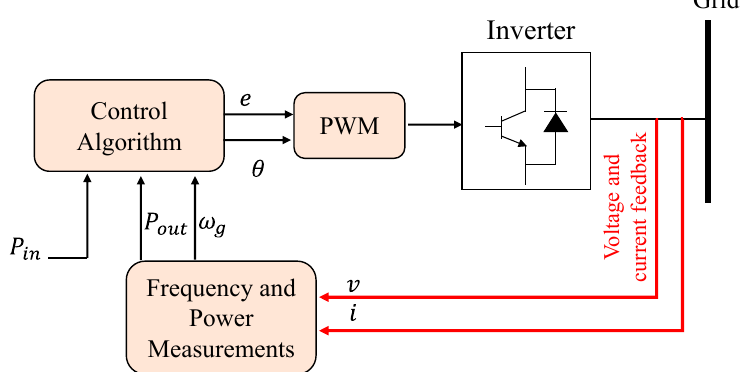
Figure 9. Overall diagram of Ise Lab’s architecture [18].